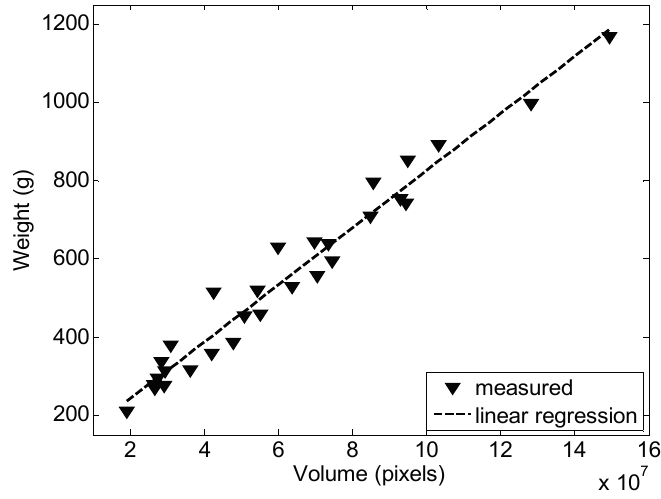
Figure 4. Relationship between the weight and volume of the cluster of grapes